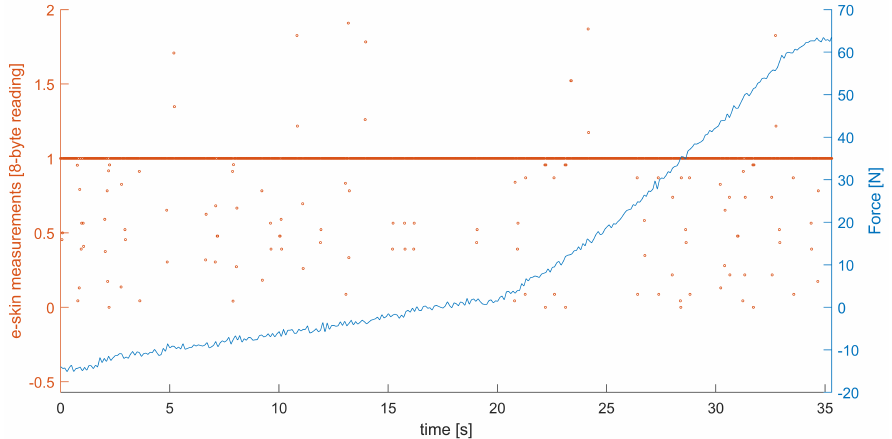
Figure 7. An example of corrupted data: results from the e-skin sensor (orange) are not valid; results from the Hex-e sensor (blue) are